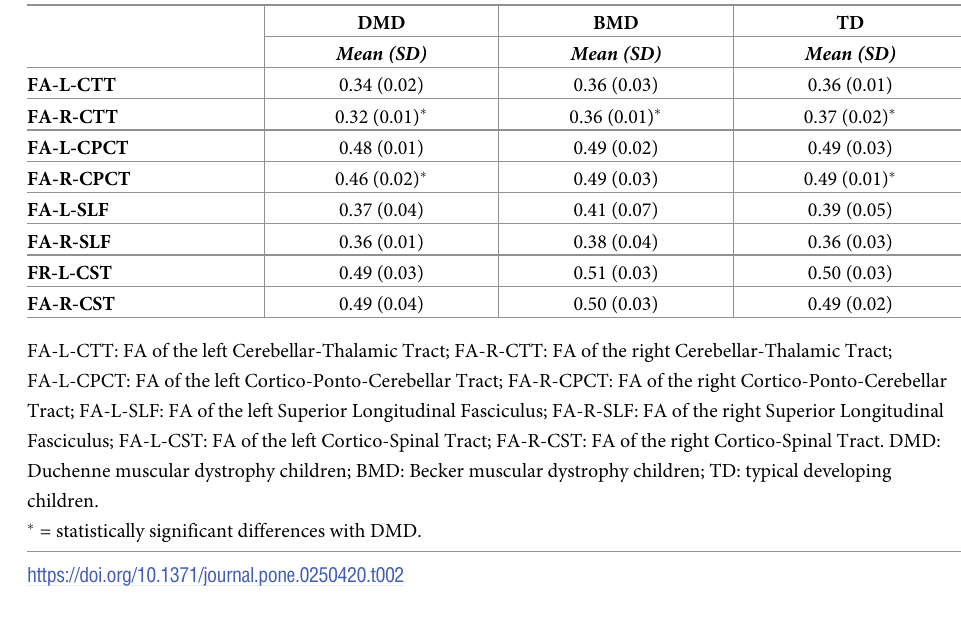
Table 2. Mean FA in all the examined tracts in DMD, BMD and TD.